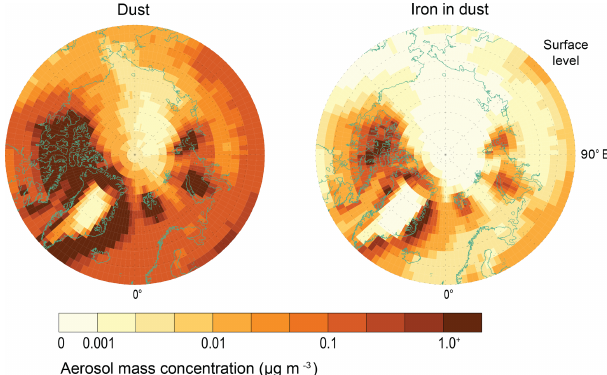
Figure 3. High-latitude ( > 60 ◦ N) dust (sum of eight mineral species and four dust–iron species) and iron (sum of four dust–iron species) mass concentrations (µg m − 3 ) at the surface model